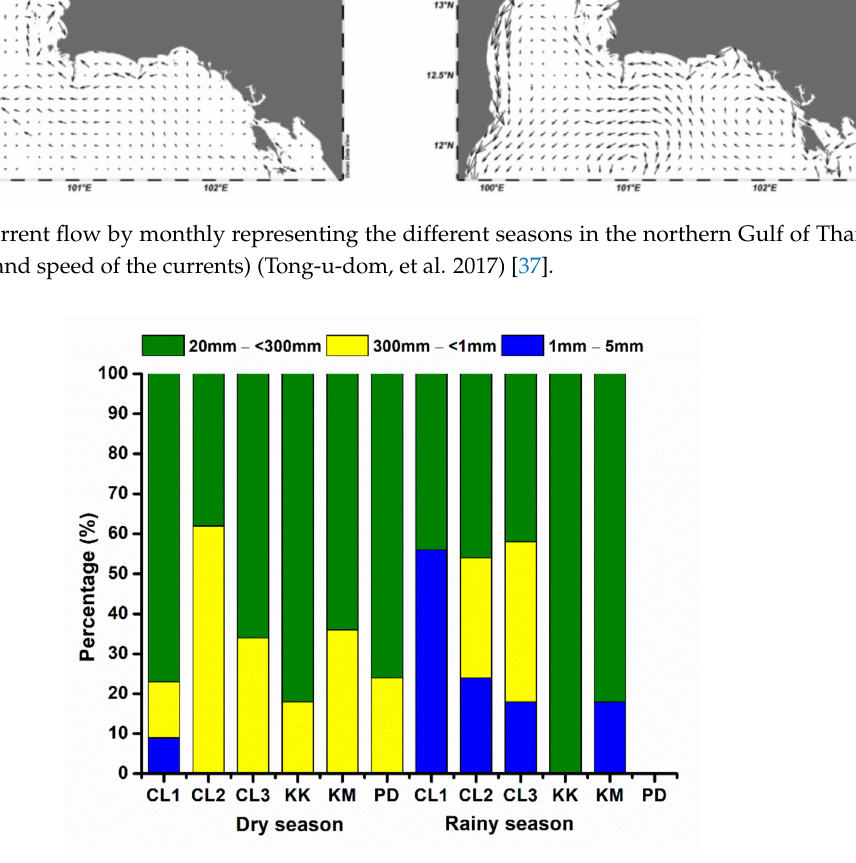
Figure 3. The percentage of three class sizes of microplastics found in beach